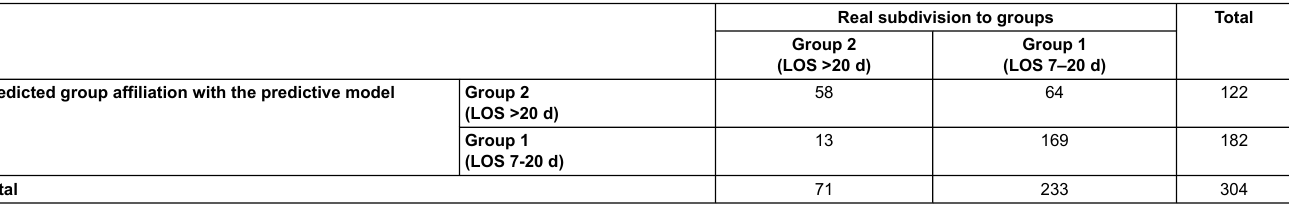
Table 4: Diagnostic characteristics of the clinically validated risk score cut off in development dataset (n =